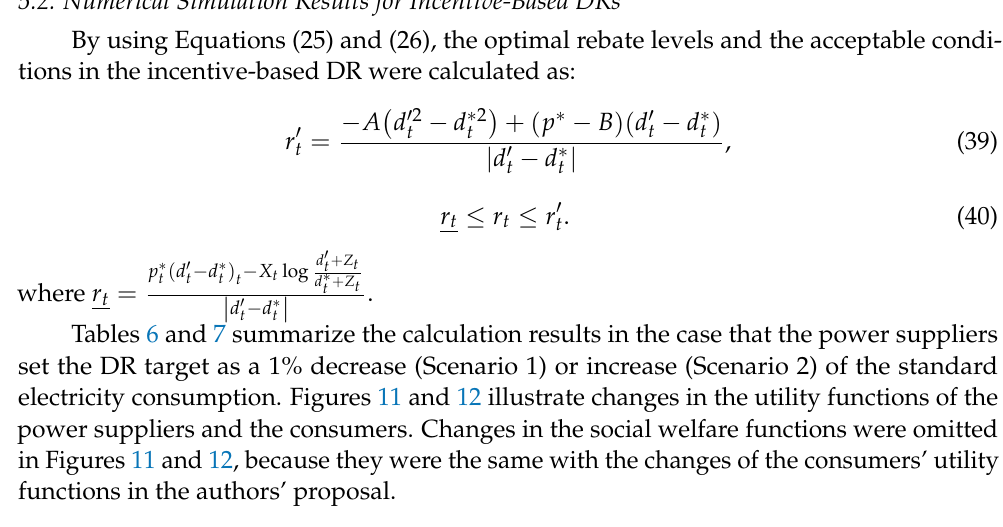
Table 6. Numerical simulation results of incentive-based DRs under scenario